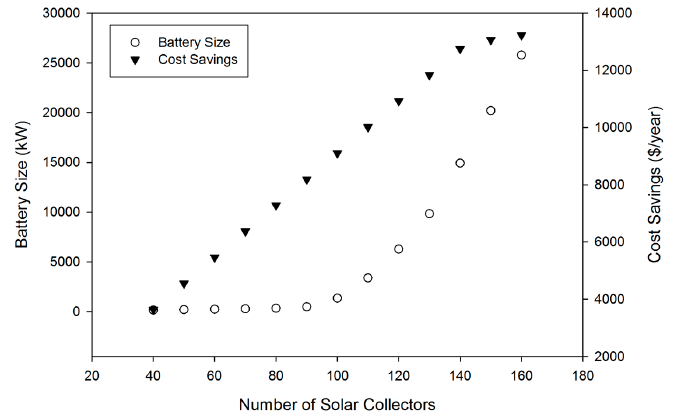
Figure 11. Battery size and cost savings of the ORC-EES verses number of solar collectors for a restaurant in Tucson, AZ.